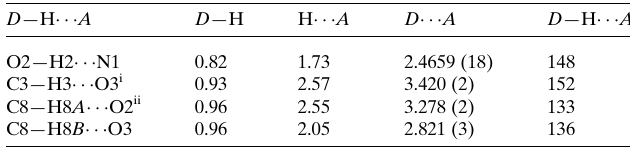
Table 1 Hydrogen-bond geometry (A˚ , (cid:4) ).